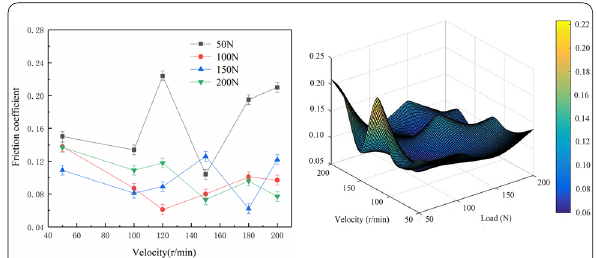
Figure 11 Experimental results of groove